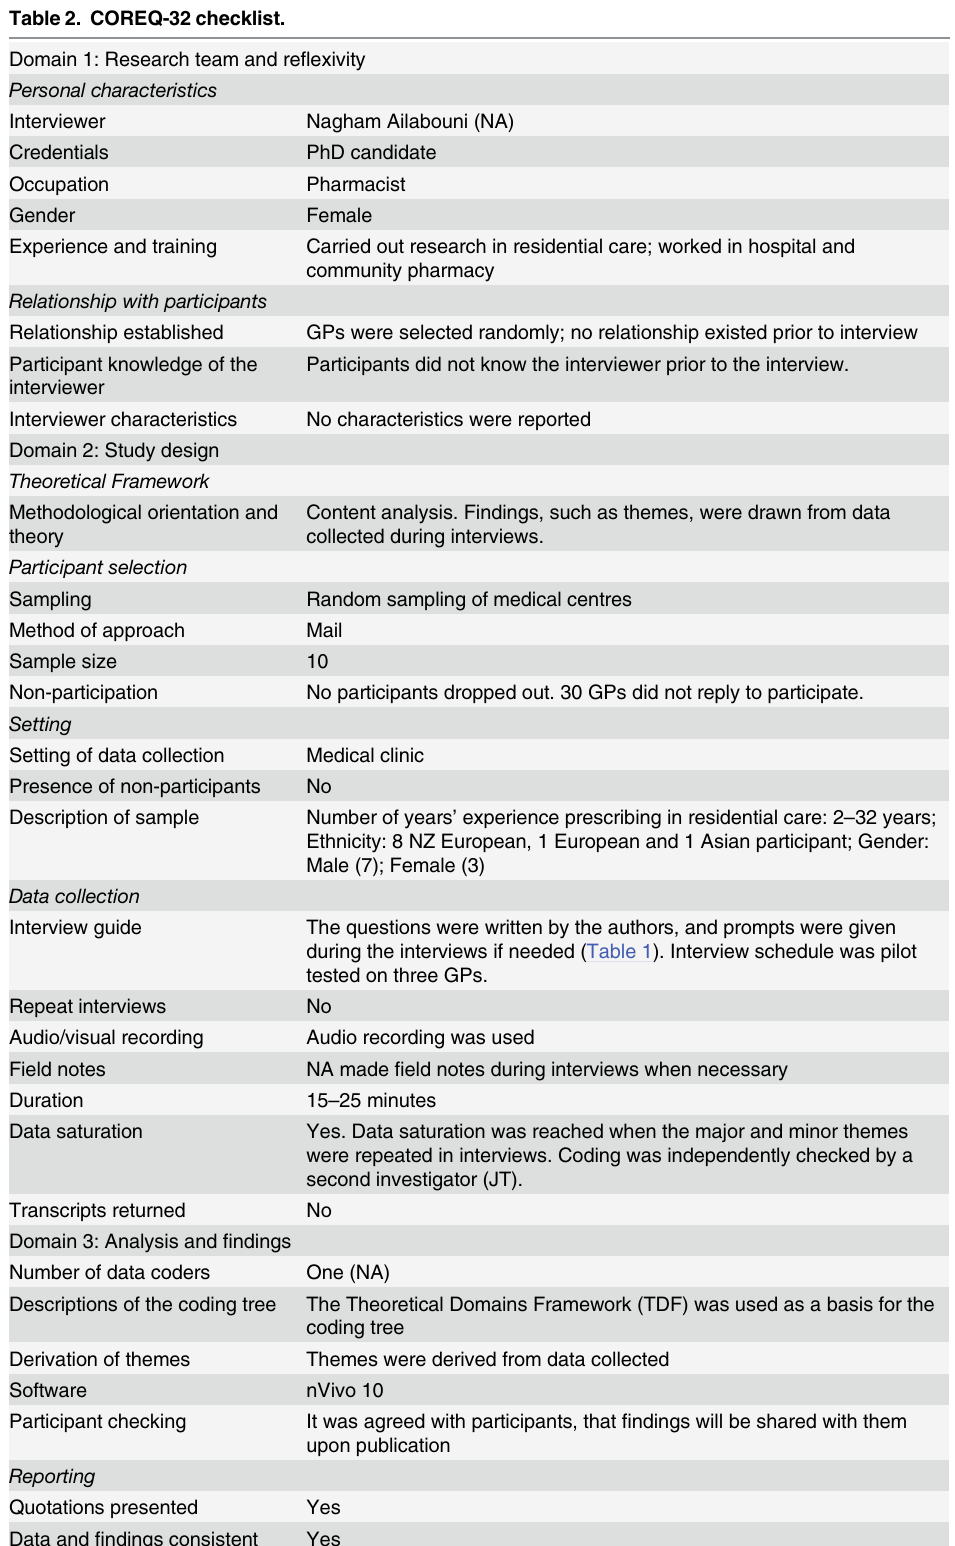
Table 2. COREQ-32